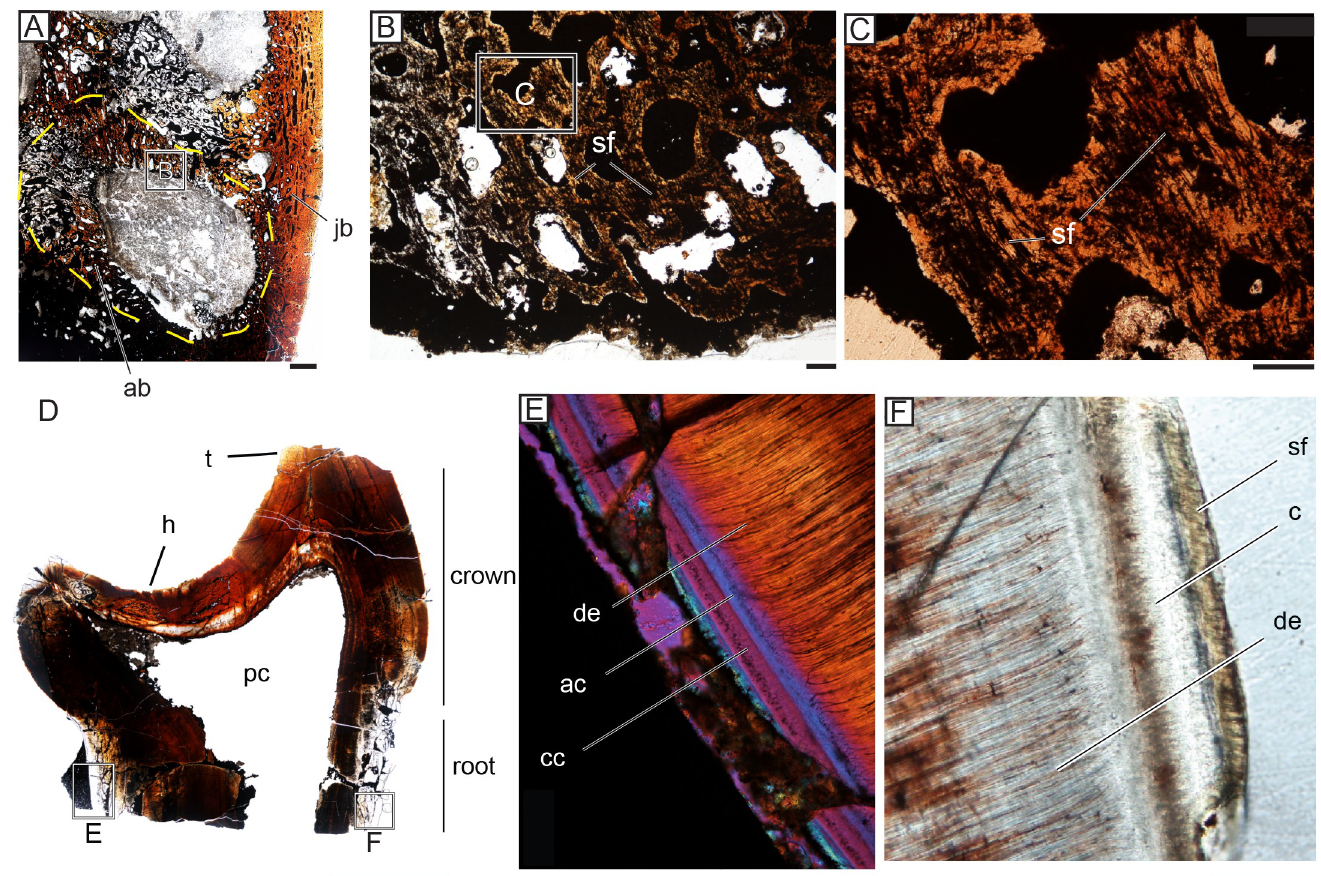
Fig 6. Evidence of a permanent gomphosis in tapinocephalid jaws and teeth. (A) Histology of NHCC LB369, an empty tooth socket with the alveolar bone outlined from jaw bone by yellow dashed line. Scale = 2000 μ m. (B) Alveolar bone from (A) with dense Sharpey’s fibers. Scale = 200 μ m. (C) Close up of Sharpey’s fibers from (B). Scale = 100 μ m. (D) Longitudinal thin section of NHCC LB733 that contains part of the root. Scale = 10000 μ m. (E) Close up of the lingual root of NHCC LB733 under polarized light with a lambda plate. Clear boundaries between the acellular and cellular cementum lining the tooth root are visible. Scale = 100 μ m. (F) Close up of the cementum of NHCC LB733 on the labial side of the root with Sharpey’s fibers under polarized light. Scale = 100 μ m. Abbreviations: ab , alveolar bone; ac , acellular cementum; cc , cellular cementum; de , dentine; h , heel; jb , jaw bone; pc , pulp cavity; sf , Sharpey’s fiber; t , talon.